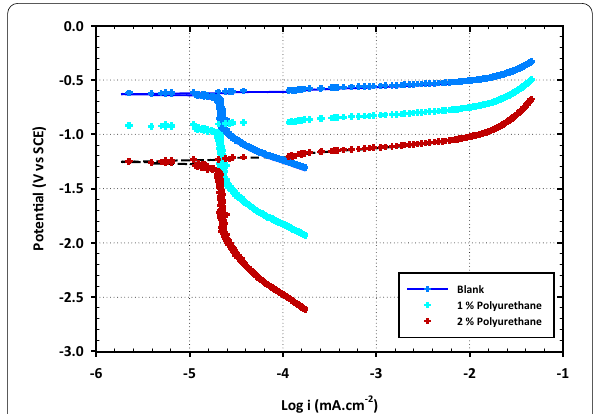
Fig. 10 Plots of potentiodynamic polarization of iron electrodes in 3.5 wt% of NaCl at gradual concentration of polyurethane